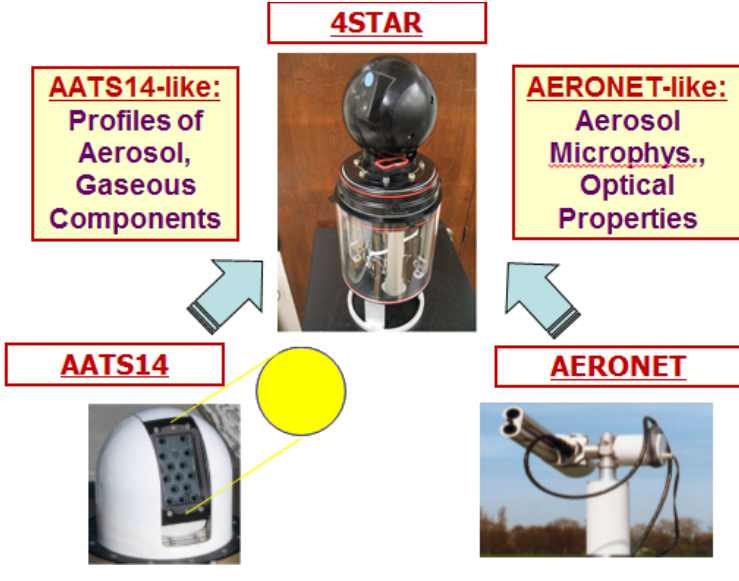
Figure 1. Schematic diagram illustrating that the 4STAR instrument combines the sun-tracking ability of the airborne AATS-14 with the sky-scanning ability of the ground-based AERONET sun/sky